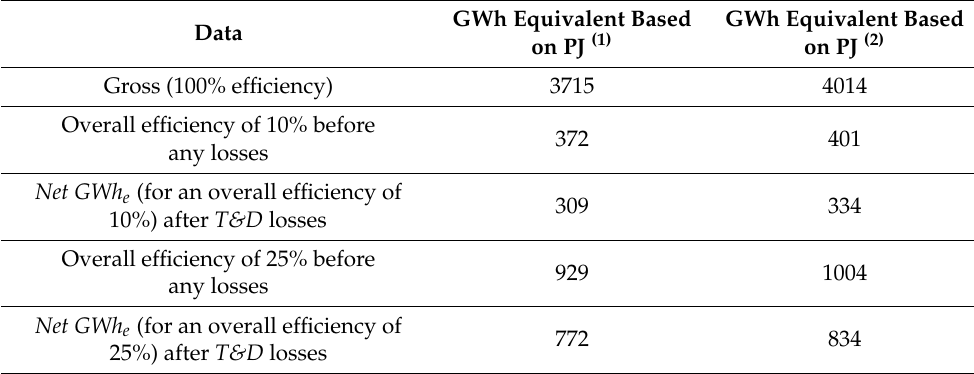
Table 8. Summary of the electrical generation potential available from forestry residues.